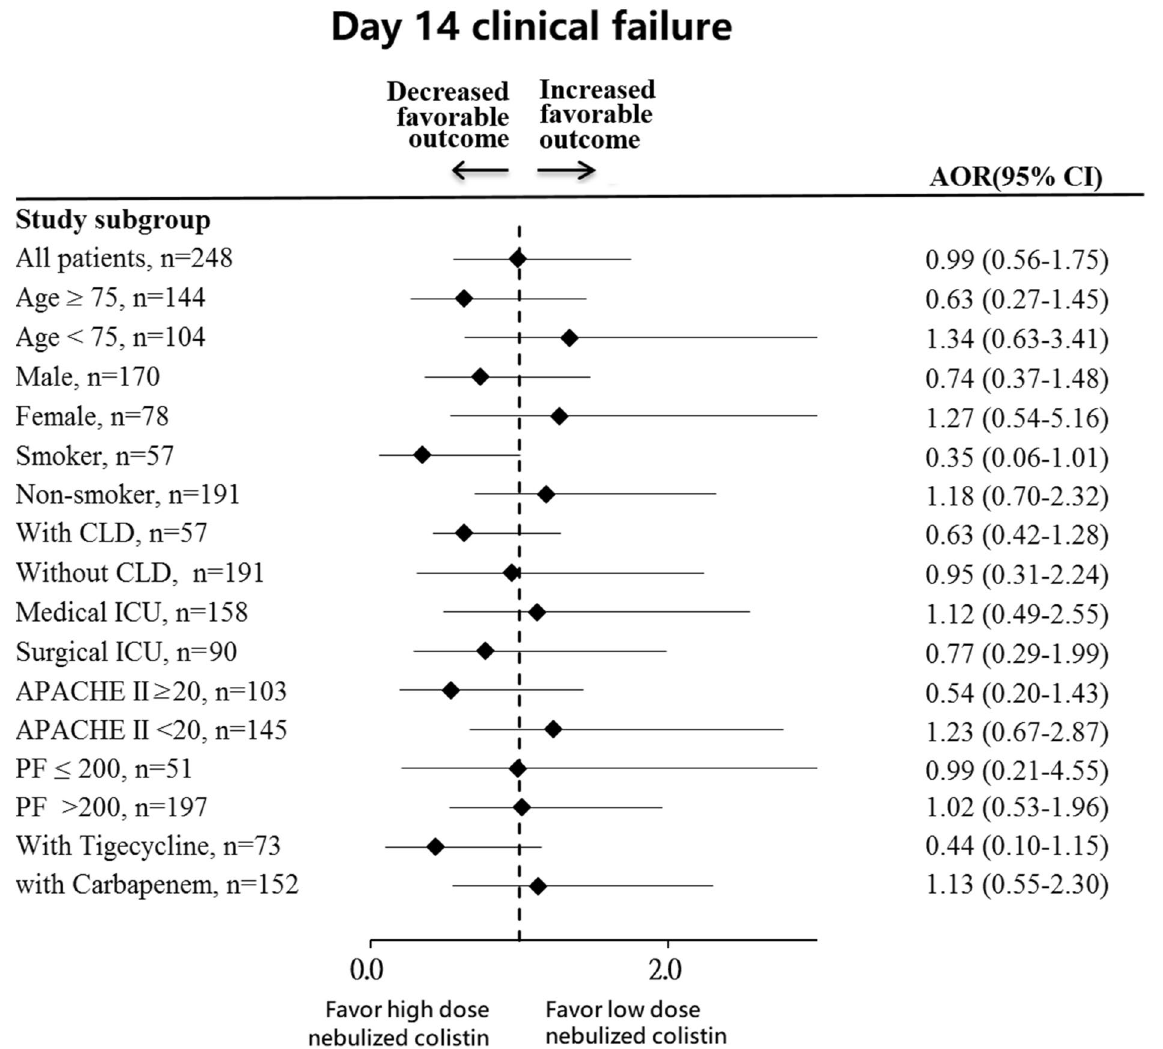
Fig. 3 Forest plot analysis for the association between substitutive nebulized colistin dosage and day‑14 clinical failure. ICU‑admitted patients with nosocomial pneumonia caused by CR‑GNB were categorized as high‑dose nebulized colistin (> 6 MIU/day CMS) and low‑dose nebulized colistin ( 6 MIU/day CMS). ICU, intensive care units; CR‑GNB, carbapenem‑resistant Gram‑negative bacteria; CLD, chronic lung disorders (including ≤ COPD, asthma, bronchiectasis, and pulmonary fibrosis); VAP, ventilator‑associated pneumonia; HAP, hospital‑acquired pneumonia; APACHE II, Acute Physiology and Chronic Health Evaluation II; PF, PaO 2 /FiO 2